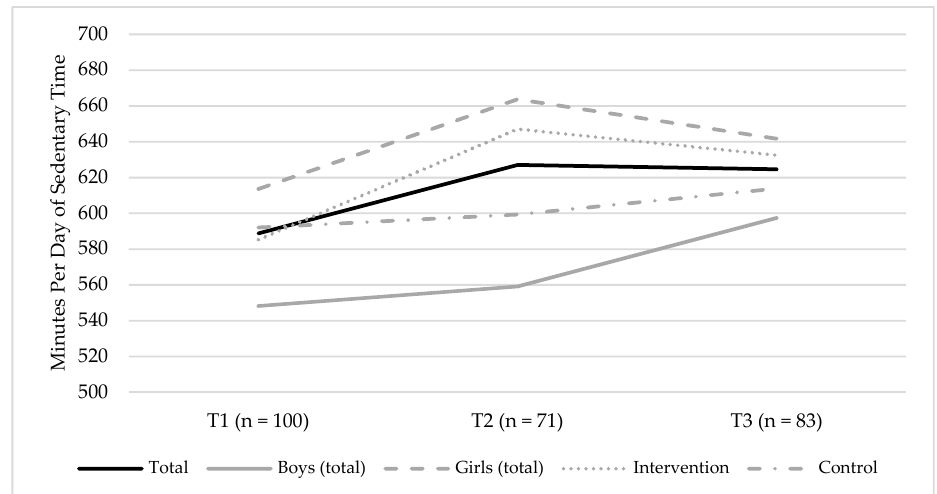
Figure 2. Changes in minutes per day of the accelerometer-measured sedentary time between T1 (baseline, 2014) and T3 (endpoint, 2016) for the total sample, boys (total sample), and girls (total sample), and the intervention and control groups, respectively. The figures show the mean group levels of sedentary time.